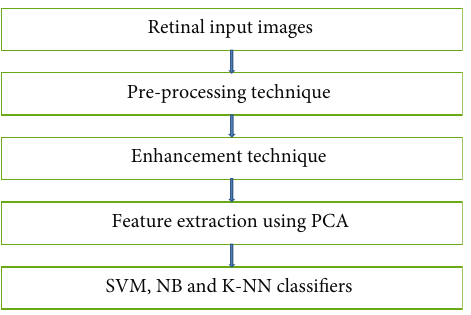
Figure 1: Work fl ow of Glaucoma